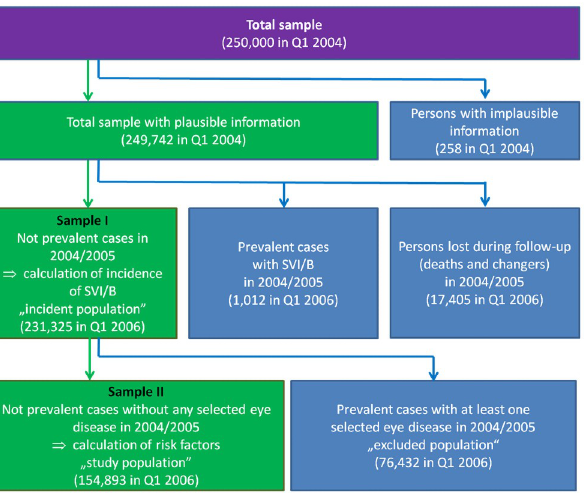
Fig 1. Scheme of analyzed sample compositions (green) and the excluded population (blue), AOK data 2004-2015.